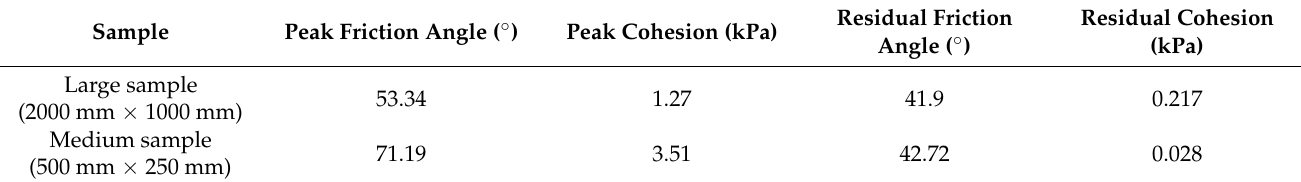
Table 4. Cohesion and friction angle according to Mohr–Coulomb failure criteria from the shear test. Sample Peak Friction Angle ( ◦ ) Peak Cohesion (kPa)